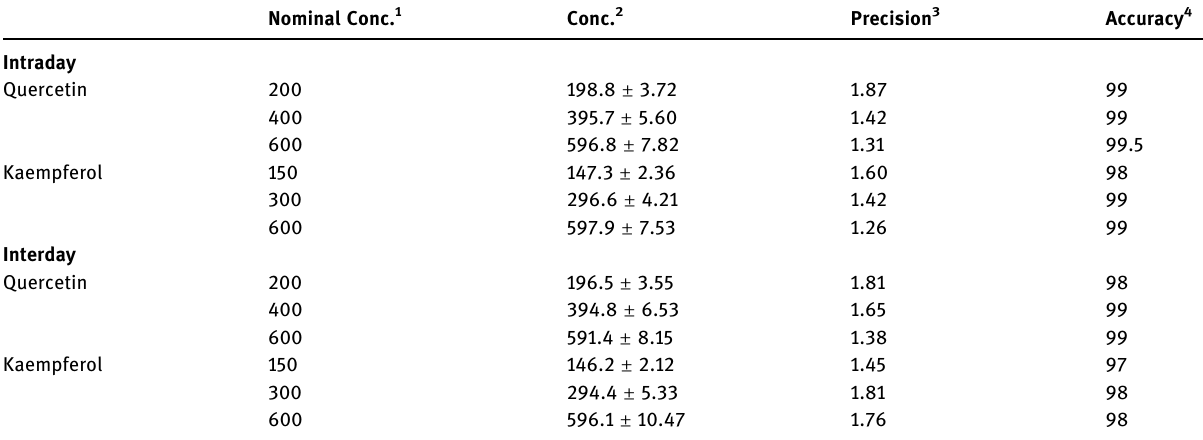
Table 5: Precision and accuracy of quercetin and kaempferol Nominal Conc. 1 Conc.